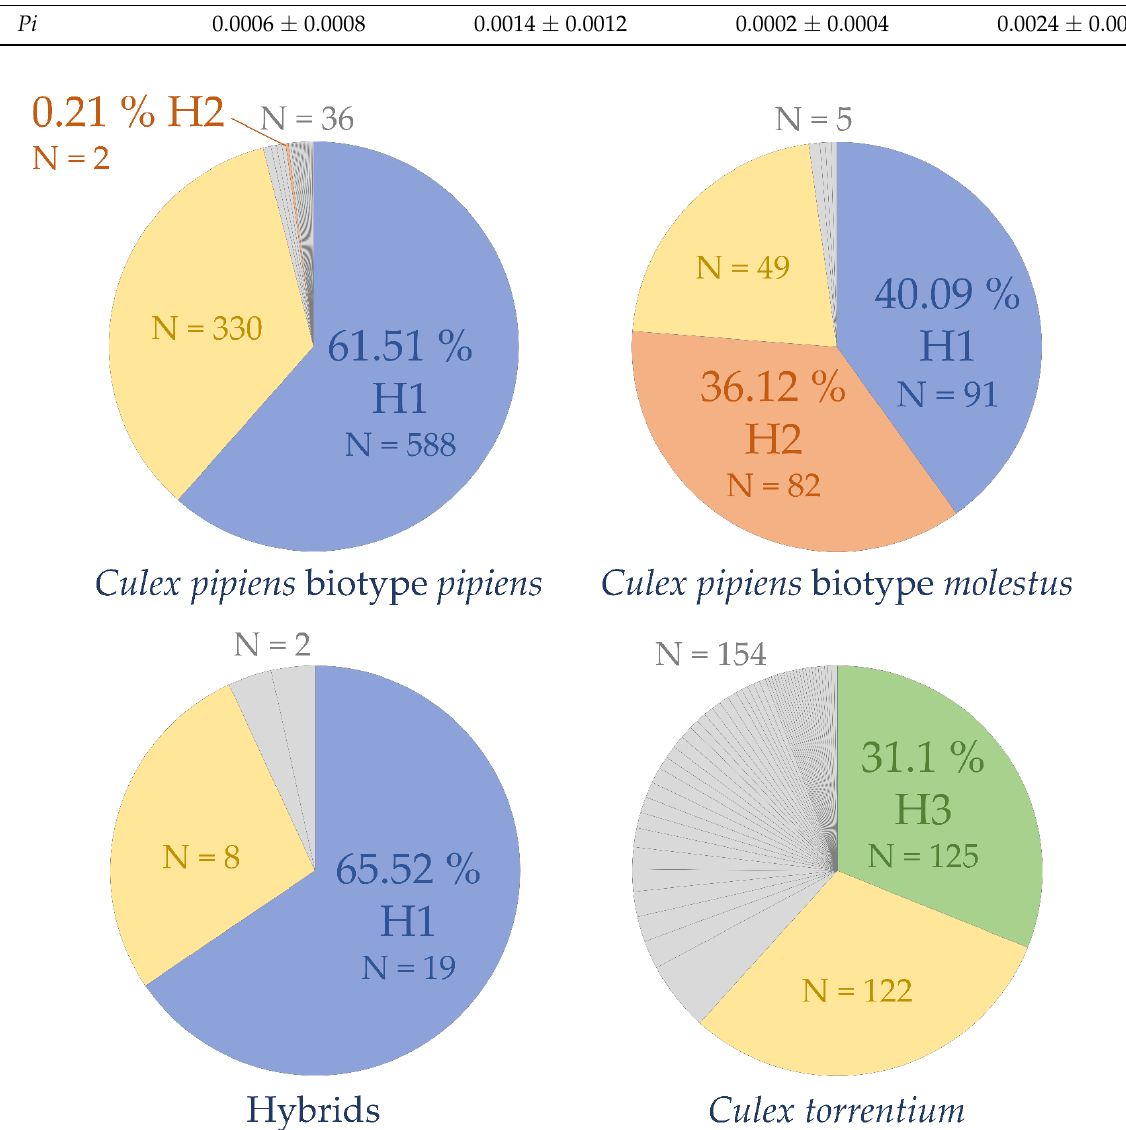
Figure 3. COI haplotype frequencies calculated with Arlequin v.3.5. [46]. Hybrids = Culex pipiens biotype pipiens X Cx. pipiens biotype molestus , blue = Cx. pipiens s.s. haplotype H1, orange = Cx. pipiens s.s. haplotype H2, green = Cx. torrentium haplotype H3, yellow = sequences to which no haplotypes could be assigned, grey = haplotypes with a frequency <